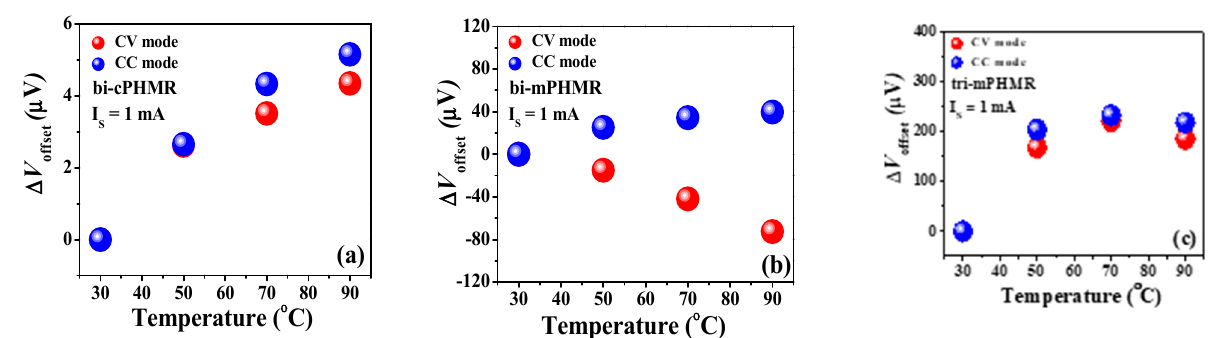
Figure 4. ( a – c ) Baseline offset drifts ( ∆ V Baseline ) with temperature change in CC and CV modes.